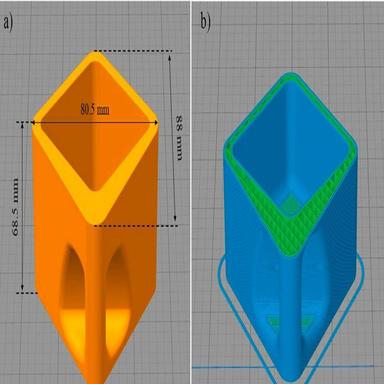
a) 3D model and b) infill pattern of the cup that had to be printed using commercial YSZ filaments.